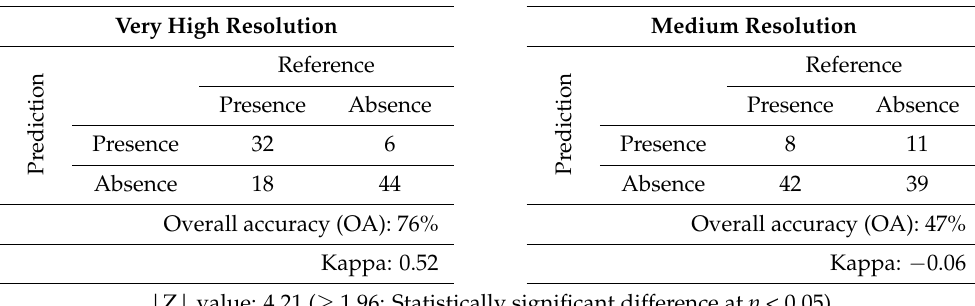
Table 4. Very-high-resolution (VHR) and medium-resolution (MR) confusion matrix obtained for the medium tree growth form (guava).